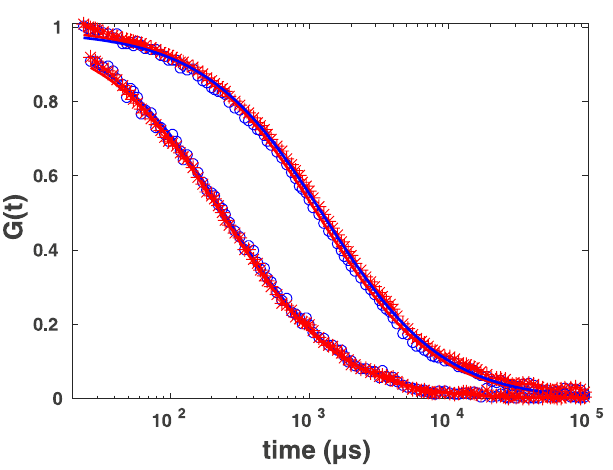
Figure 6. Experimental results for FCS calculated from photon counts (blue circles) and from the restored intensity trace according to Eq. 9 (red asterisks) for streptavidin diffusion in pure PBS (lower line/symbols) and in PBS crowded with 30% PEG1500 (upper line/symbols) fitted to the standard formula (solid lines). Each curve is representative for N = 6 independent